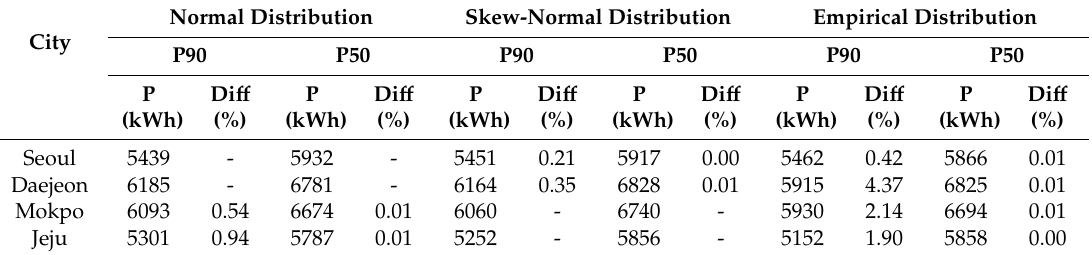
Table 6. P90 and P50 PV power potentials of four cities.